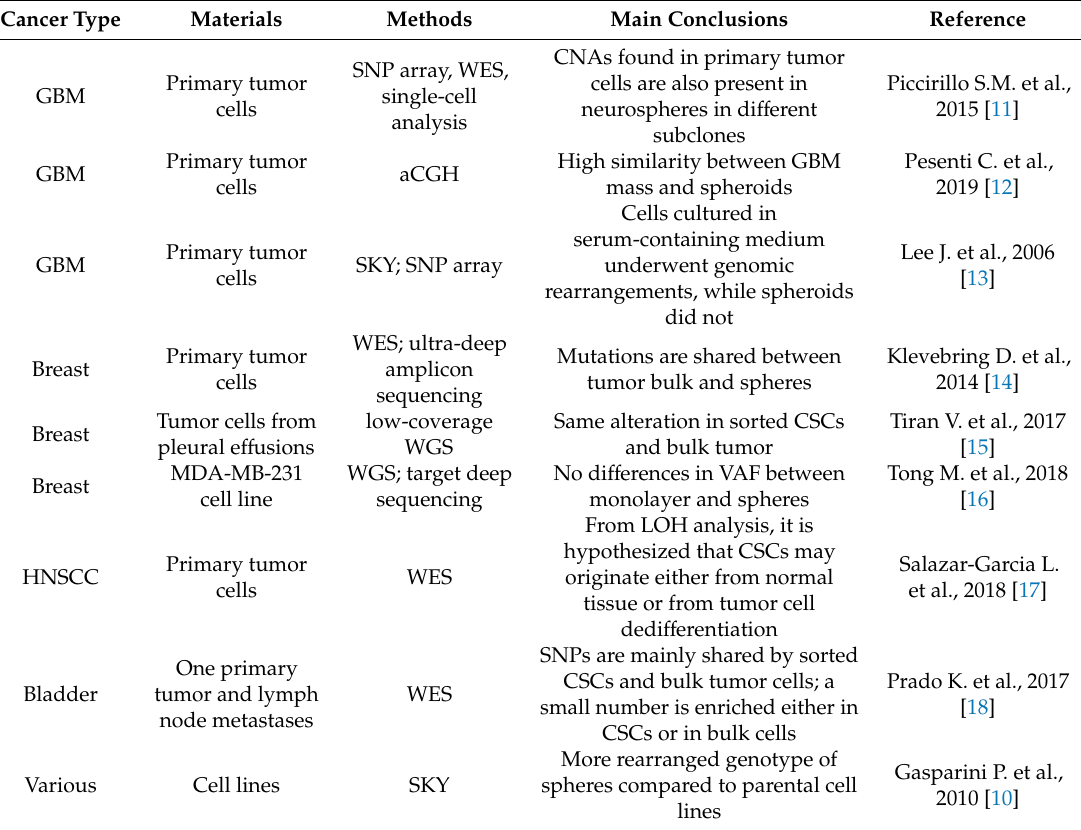
Table 1. Studies on genetic alterations in